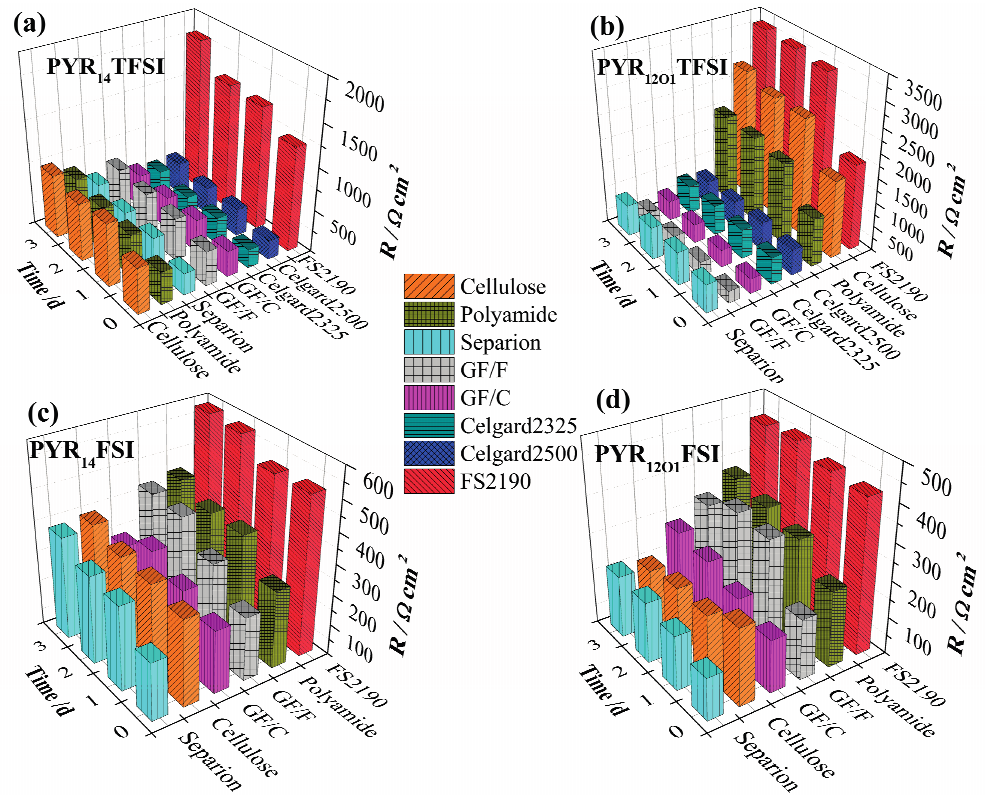
Figure 3. Evolution of the SEI resistance of Li electrodes in contact with 10% mol LiTFSI electrolytes combined with different separators ( a ) PYR ( c ) PYR FSI; and ( d ) PYR 14 12O1